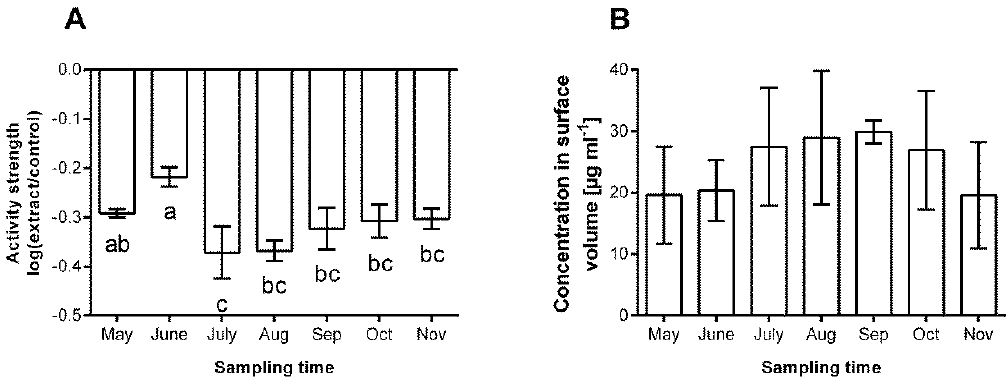
Figure 3. Seasonal variation of ( A ) the mean antisettlement activity of propan-2-ol surface extract from Z. marina against four different bacteria ( B. aquimaris , A. stellipolaris , L. rosea , and P. dokdonensis ) and ( B ) rosmarinic acid concentrations on Z. marina surfaces. (Mean ± SD, n = 4). In ( A ) increasingly negative values indicate increasing activity strength. Months that are significantly different (Tukey’s post hoc test, p < 0.05) are marked by different letters. Table 3. Repeated measures ANOVA of (A) the mean antisettlement activity of propan-2-ol surface extract from Z. marina against four different bacteria ( B. aquimaris , A. stellipolaris , L. rosea , and P. dokdonensis ) and (B) rosmarinic acid concentrations on Z. marina surfaces. Within-measures factor was the month of sampling.